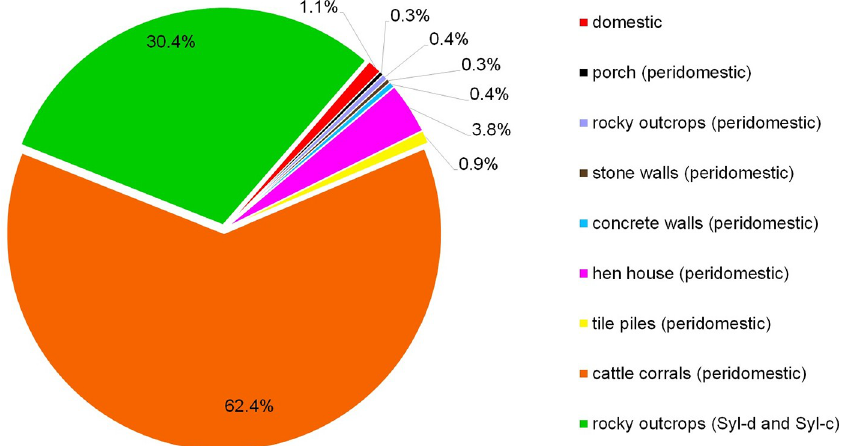
Fig 2. Triatoma b . brasiliensis infestation in the peridomestic and sylvatic ecotopes from Pedregulho, Ina´cio, S ã o Bernardo de Elias, Riacho do Santo, and Batalh ã o de Engenharia de Construc¸ ã o localities in the Caico´ municipality, Rio Grande do Norte,